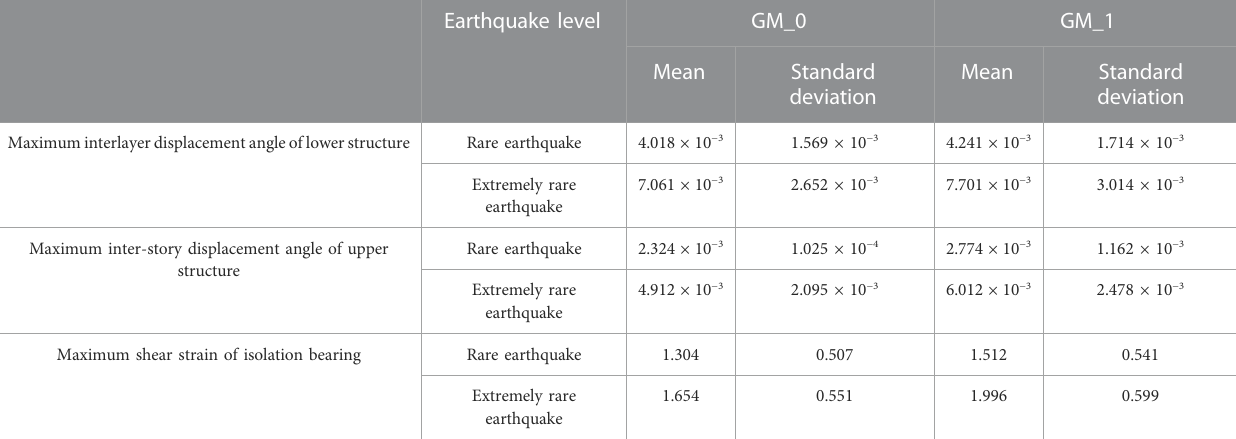
TABLE 8 Probabilistic characteristic parameters of structural response values at 50% stiffness.